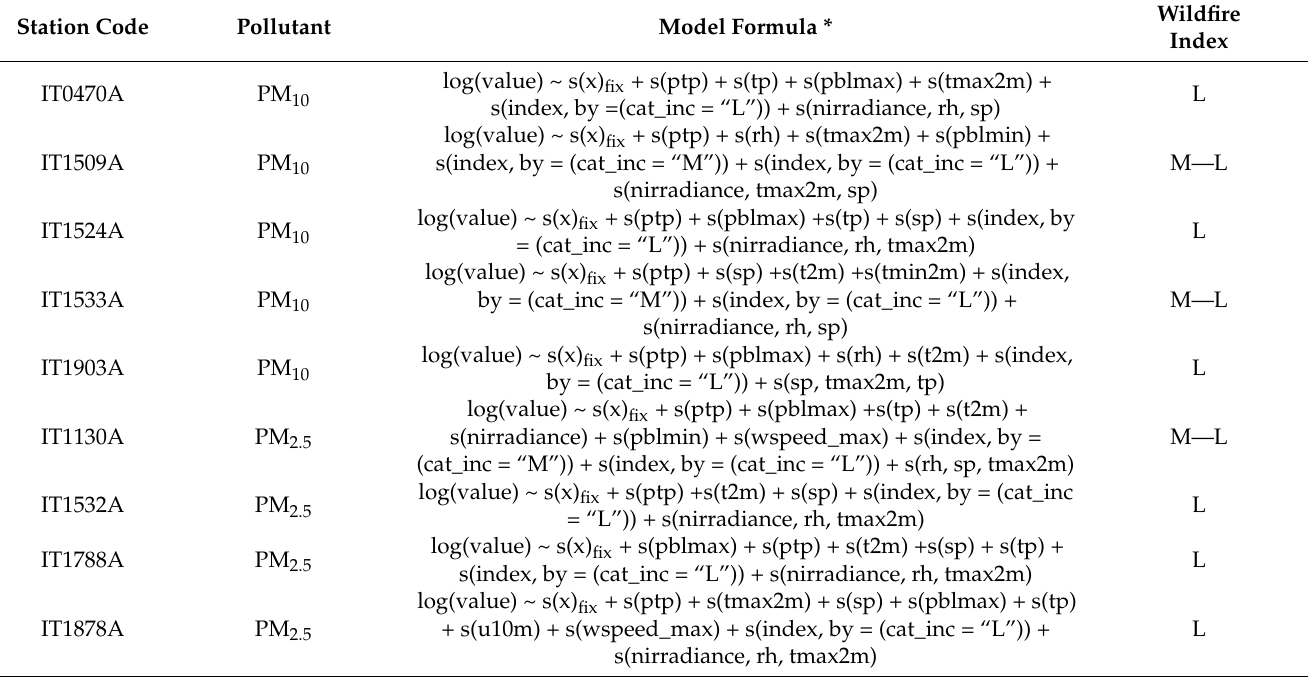
Table 4. Model formula for each station.